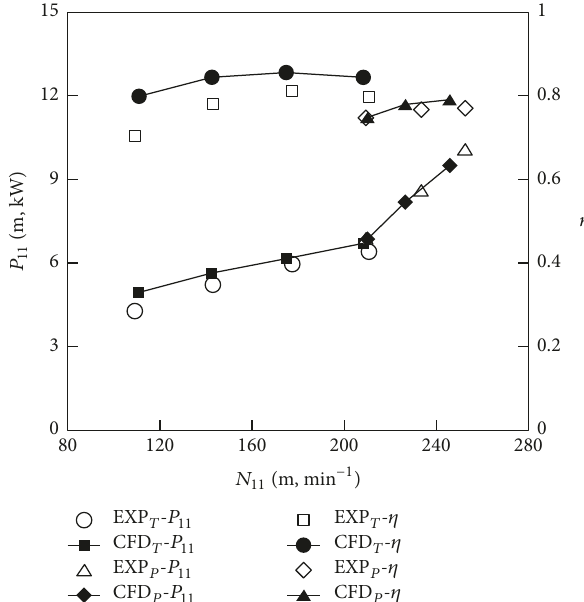
Figure 2: Computational domain and methods.